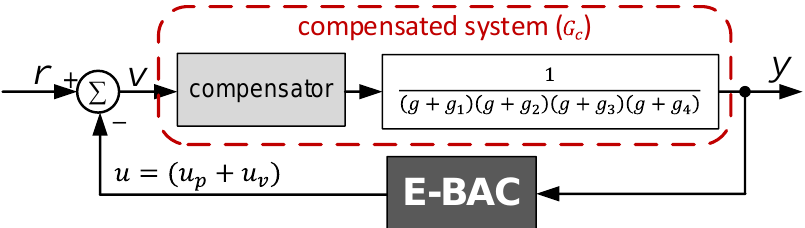
Figure 14. Schematic block diagram of a compensated system of the motorized hybrid soft leg with a compensator and E-BAC.